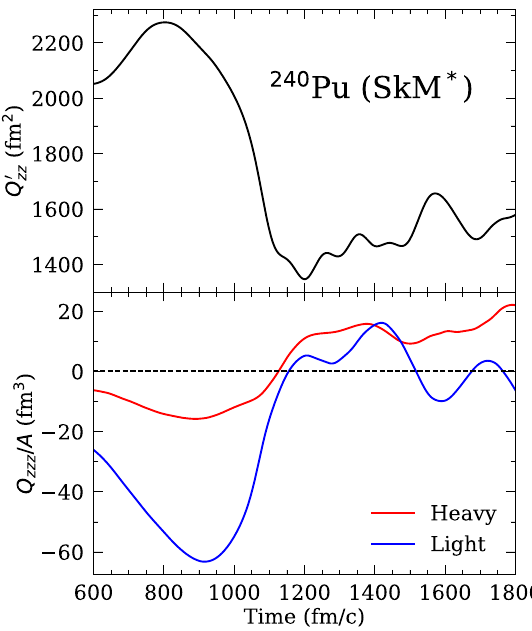
Figure 2. Evolution of the quadrupole moment (of the whole system) and of the octupole moment (of the fragments) from before to after scission.